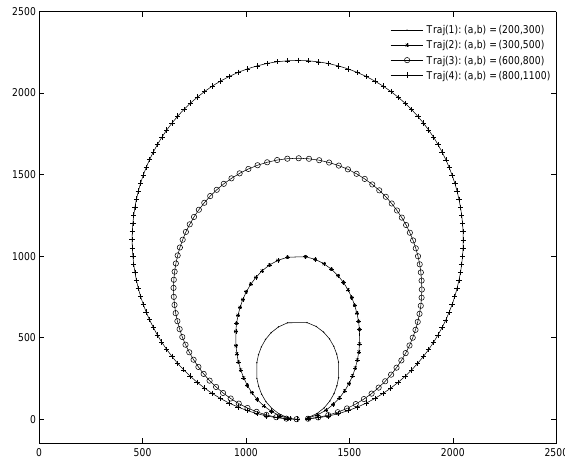
Figure 3. Elliptical trajectories of one AUV.